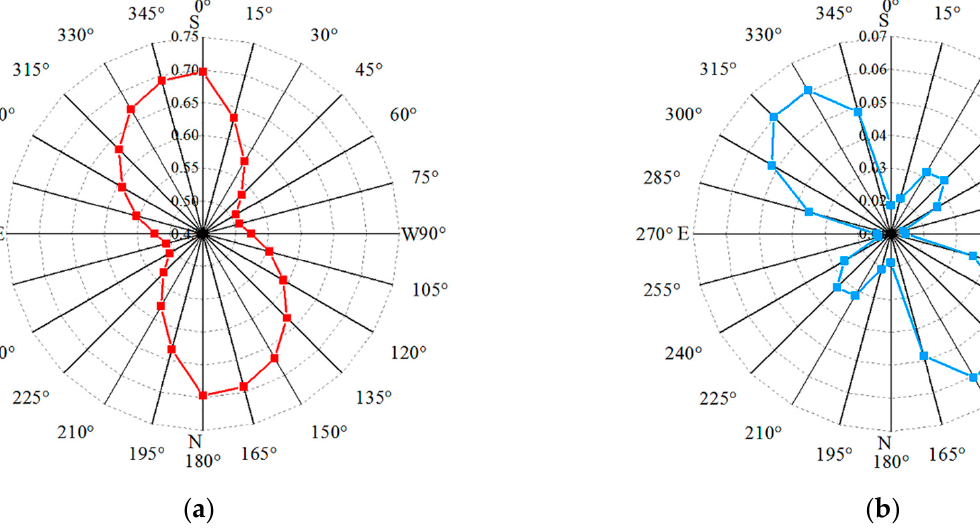
Figure 11. Variation of the annual average effective tracking factor σ y and SD y of an SDC system under different azimuth axis tilt errors: ( a ) annual average effective tracking factor σ y ; and ( b ) SD y . Since the tangential angle of azimuth axis is symmetrical about the origin, its tracking error is the same. Therefore, only some of the data are listed. Figure 12 shows the variation of the monthly average effective tracking factor σ m of an SDC system for different azimuth axis tilt errors. It can be seen that when the azimuth axis tangential angle φ 1 = (0 ◦ , 90 ◦ ), the monthly average effective tracking factor first increases and then decreases, i.e., the tracking performance first increases and then decreases. When the azimuth axis tangential angle φ 1 = (90 ◦ , 180 ◦ ), the monthly average effective tracking factor first decreases and then increases, i.e., the tracking performance first decreases and then increases. When the azimuth axis tangential angle φ 1 = 0 ◦ (due south) or 90 ◦ , this is the turning point of the effective tracking factor variation rule of an SDC system. In particular, when the azimuth axis tangential angle φ 1 = 0 ◦ , the monthly average effective tracking factor varies in a “wavy”